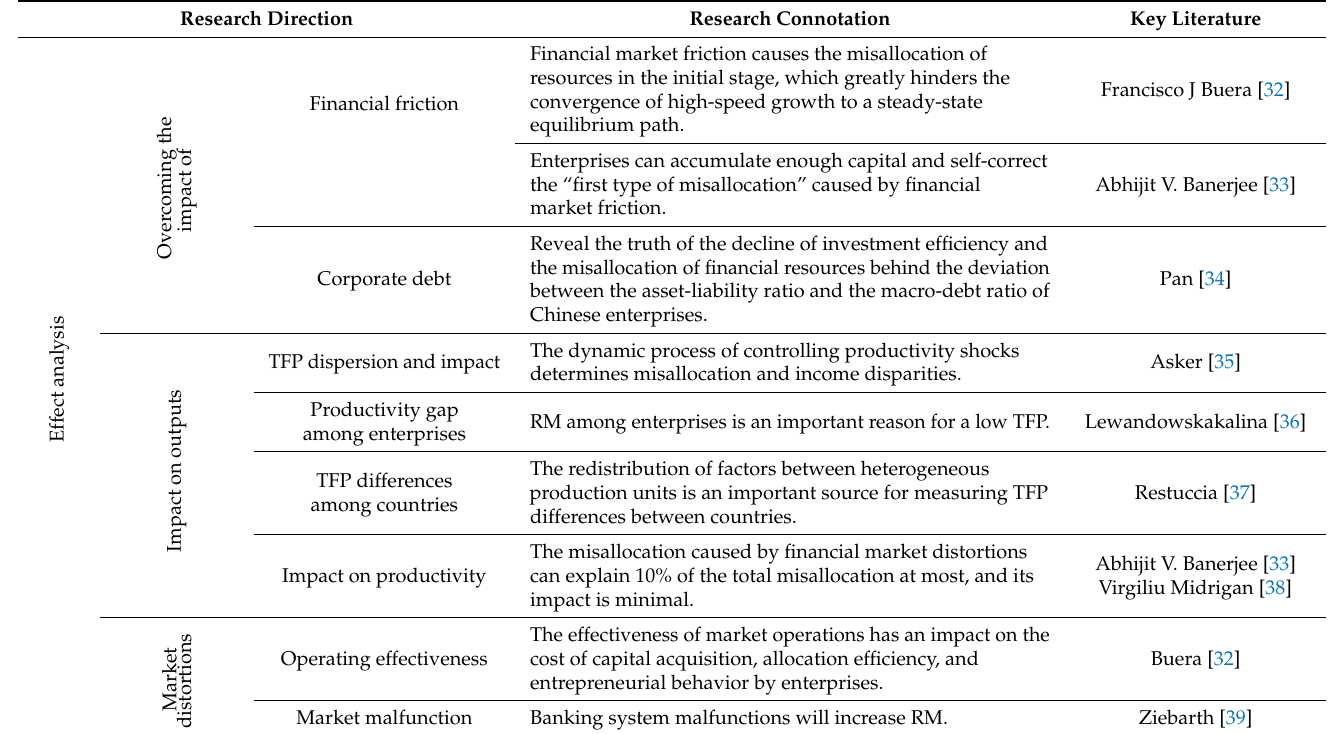
Table 3. Key literature relating to focused issues